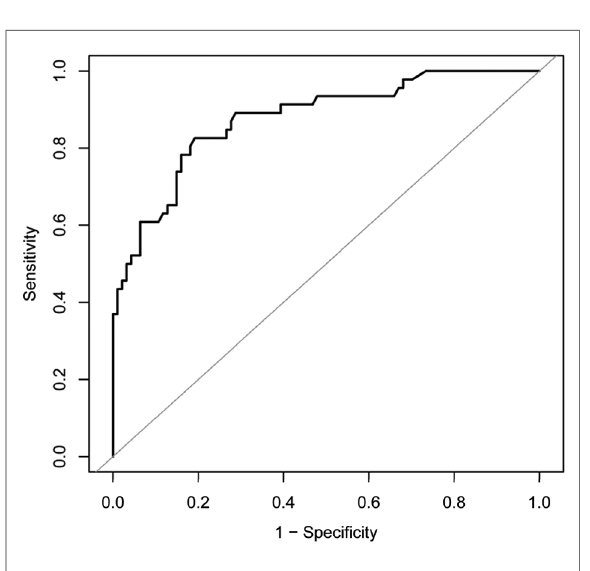
FIGURE 2 ROC curve for preoperative serum ALP receiver operating characteristic; ALP, alkaline phosphatase; AUC, area under the curve.